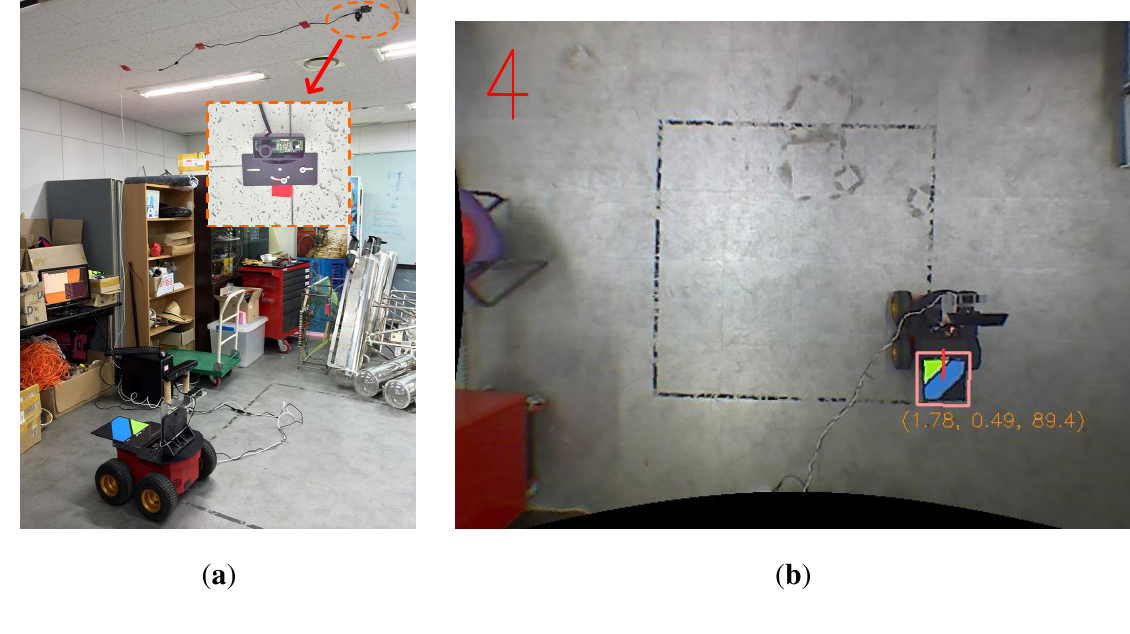
Figure 15. Global vision system for obtaining the ground truth position. ( a ) Camera installed on the ceiling; ( b ) Global positioning result is displayed. A 3-DOF robot pose ( x, y, θ ) is obtained.